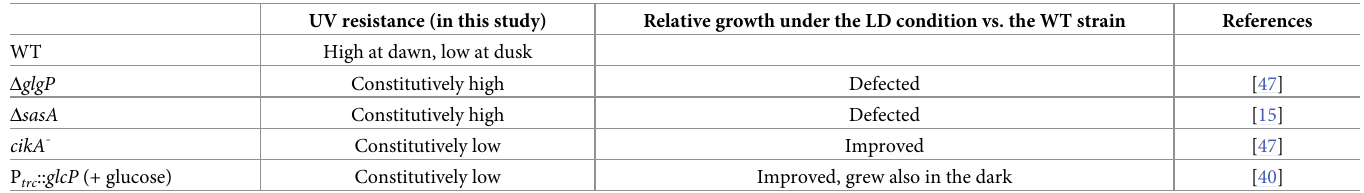
Table 1. Summary of UV resistance properties and growth of each strain under the LD condition. UV resistance (in this study) Relative growth under the LD condition vs. the WT